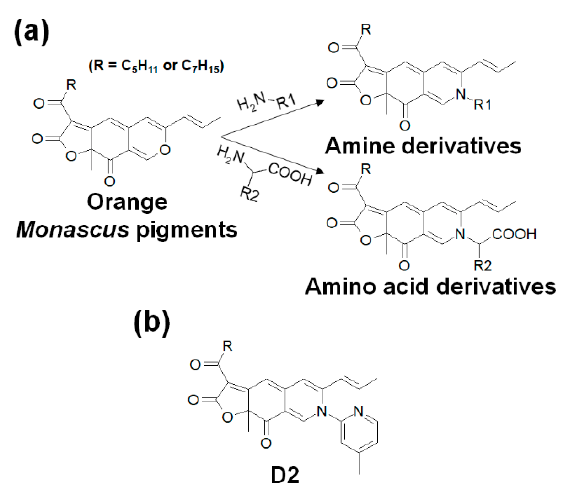
Figure 1. Synthesis of amine and amino acid derivatives from orange Monascus pigments ( a ) and the molecular structure of the 2-amino-4-picoline (D2) derivative of Monascus pigment ( b ).